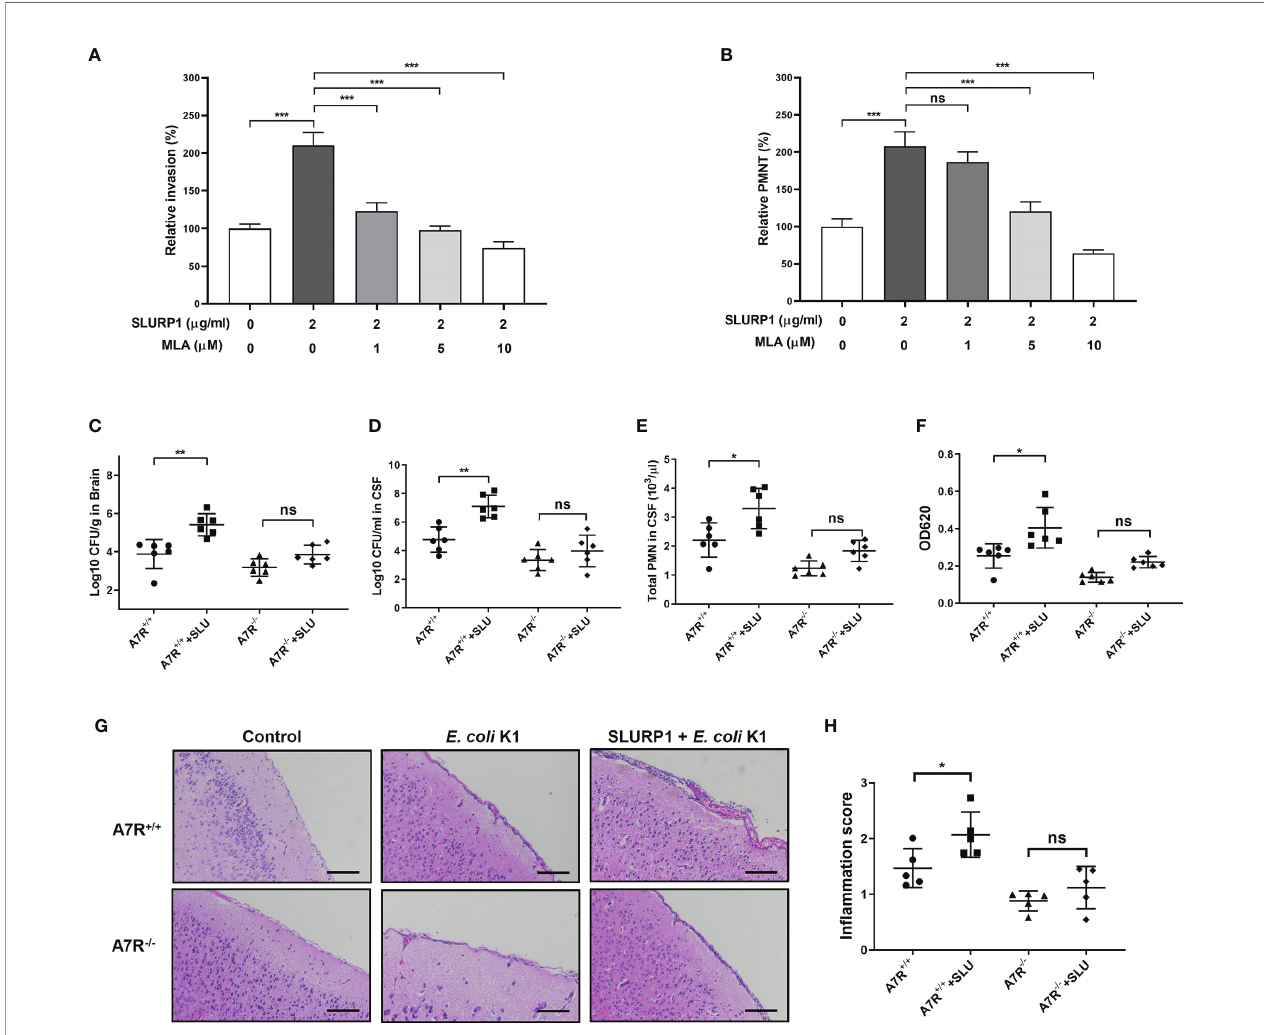
FIGURE 5 | Effects of a 7 nAChR knockout on SLURP1-enhanced E coli K1 entry into the CNS and PMN transmigration across the BBB. (A) The invasion of E coli K1 into HBMEC which pretreated with indicated doses of SLURP1 or SLURP1+ a 7 nAChR inhibitor MLA. Data are presented as percent of the control values. (B) E coli K1-induced PMN transmigration across the HBMEC monolayers which pretreated with indicated doses of SLURP1 or SLURP1+ a 7 nAChR inhibitor MLA. Data are presented as percent of the control values. (C, D) Pathogen counts in the brain tissues (C) or CSF (D) of E coli K1-infected wild type (A7R +/+ ) or a 7 nAChR knockout (A7R − / − ) mice pretreated with or without SLURP1 (100 mg/kg body weight). (E) PMN counts in the CSF of E coli K1-infected A7R +/+ or A7R − / − mice pretreated with or without SLURP1 (100 mg/kg body weight). (F) Measurement of the BBB permeability by Evans blue assay in E coli K1-infected A7R +/+ or A7R − / − mice administrated with or without SLURP1 (100 mg/kg body weight). (G) Representative H&E staining of the brain cortex sections, scale bar, 200 m m, and (H) meningeal in fl ammation score. The H&E staining are representative of two independent experiments (G) . Data are presented as mean ± SEM from two independent experiments. Each dot indicates an individual mouse. * p < 0.05; ** p < 0.01; *** p < 0.001 by one-way ANOVA followed by Bonferroni post-hoc test (A – F , H) . ns, not signi fi